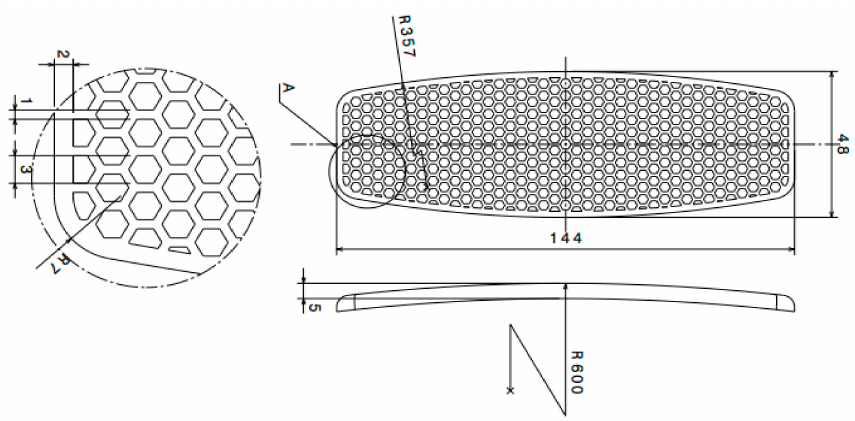
Figure 2. Geometrical dimensions of the board with a honeycomb structure core (all the dimensions are in